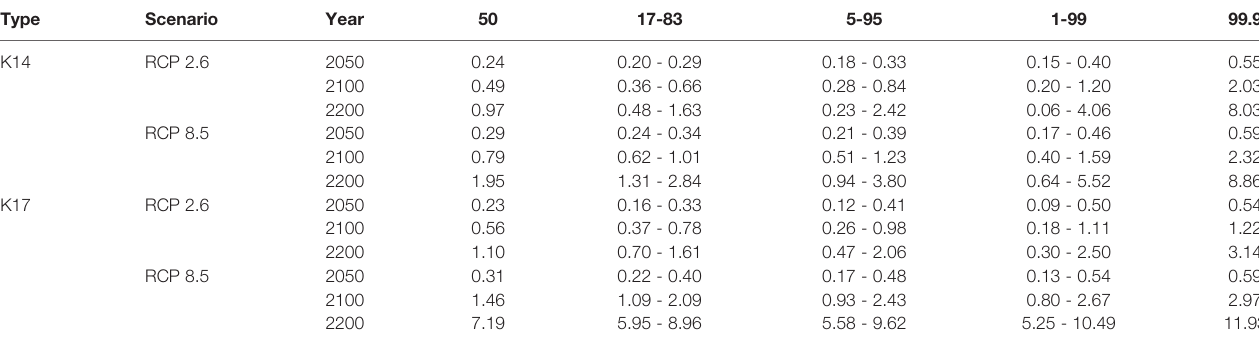
TABLE 1 | Percentiles of projected sea-level rise (in meters) for the different RCP scenarios (from Kopp et al., 2017).